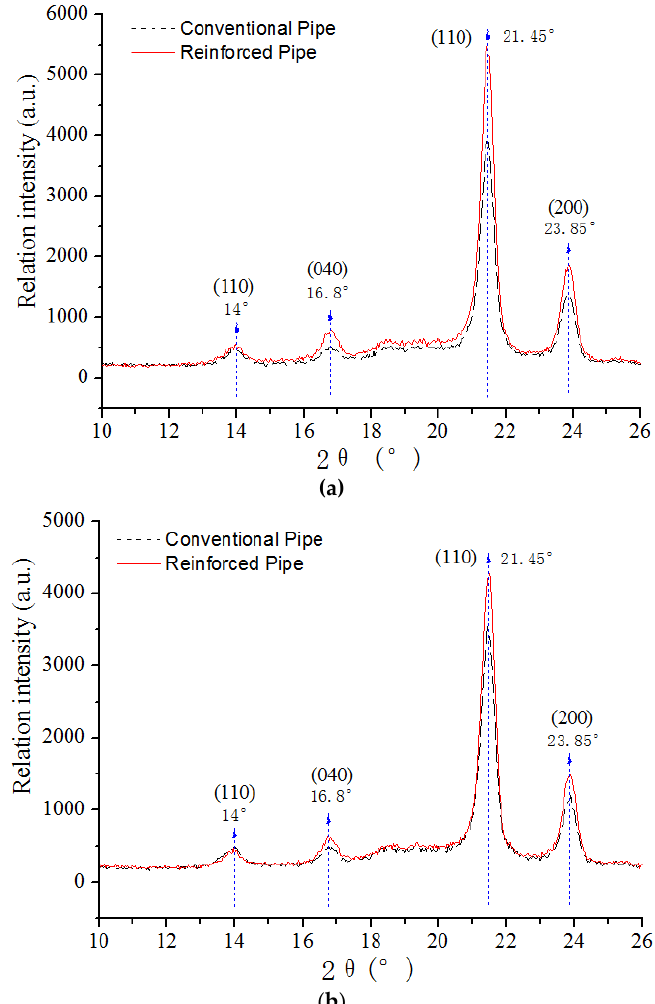
Figure 4. WAXD curves for the ( a ) circular direction and ( b ) axial direction.